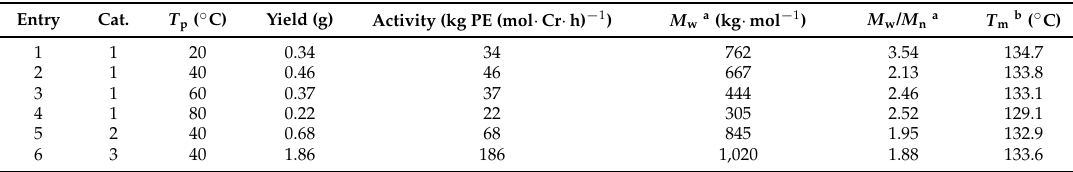
Table 1. Ethylene polymerizations with 1–3 /MAO.